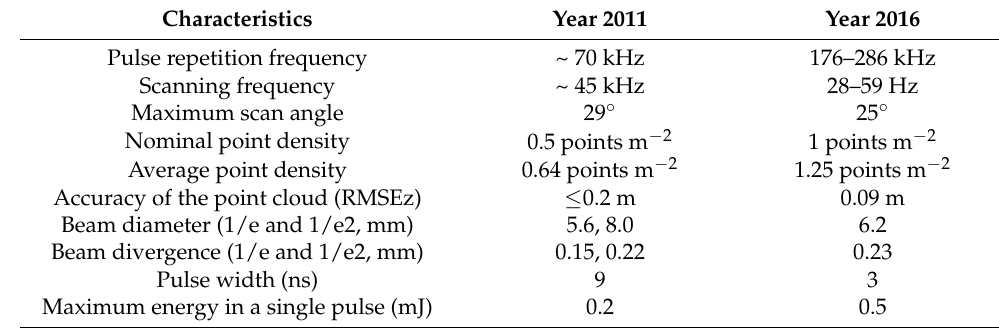
Table 1. Technical specifications of Airborne Laser Scanning (ALS) data. RMSEz stands for Root Mean Square Error in height, mJ stands for millijoule, e stands for Euler number, ns stands for nanoseconds, kHz stands for